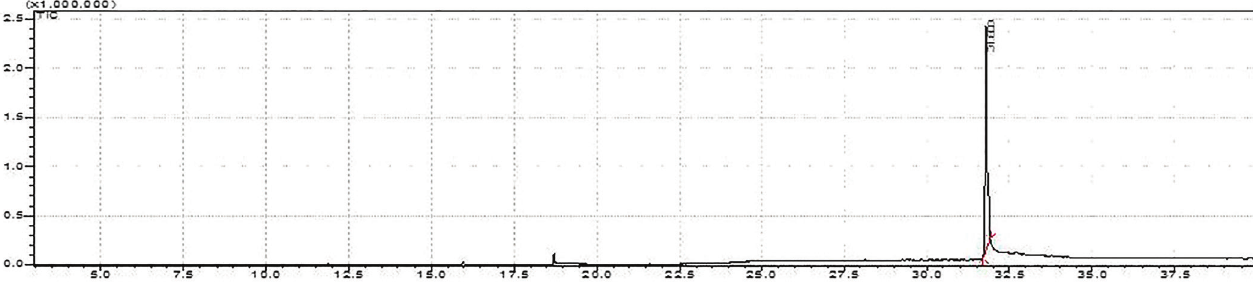
FIGURE 5 - Chromatogram obtained by GC-MS of β- amyrin obtained from the hexane partition (HP) of P. mucronata crude